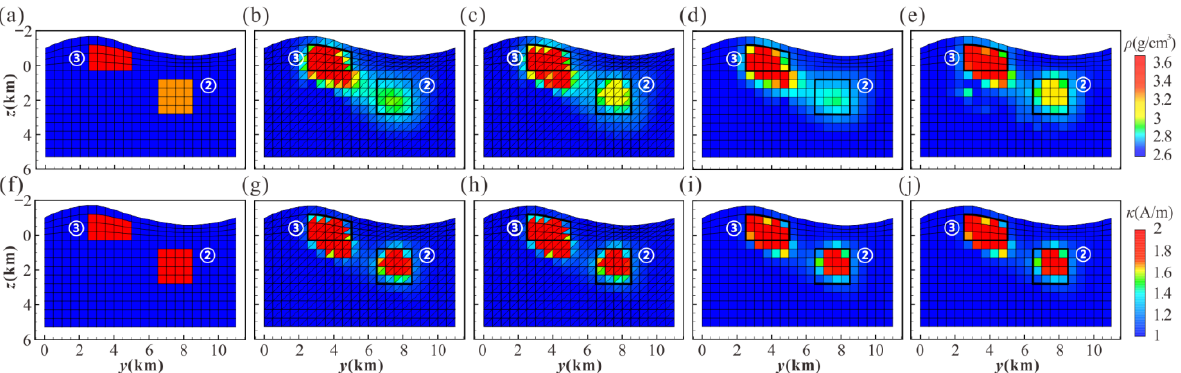
Figure 14. Slice of density (up) and magnetization (down) at x = 7500 m. ( a , f ) Real model; ( b , g ) separate result under tetrahedral grid; ( c , h ) joint result under tetrahedral grid; ( d , i ) separate result under combined hexahedral grid; ( e , j ) joint result under combined hexahedral grid.